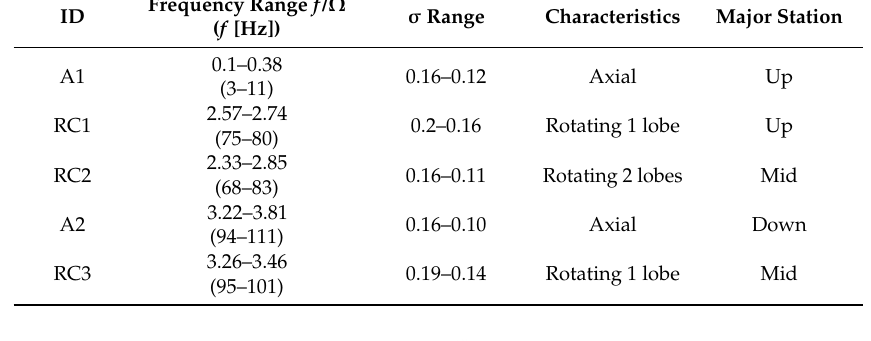
Table 8. Summary of the found instabilities at Φ N = 0.108. Abbreviations: RC, rotating cavitation; A, axial.